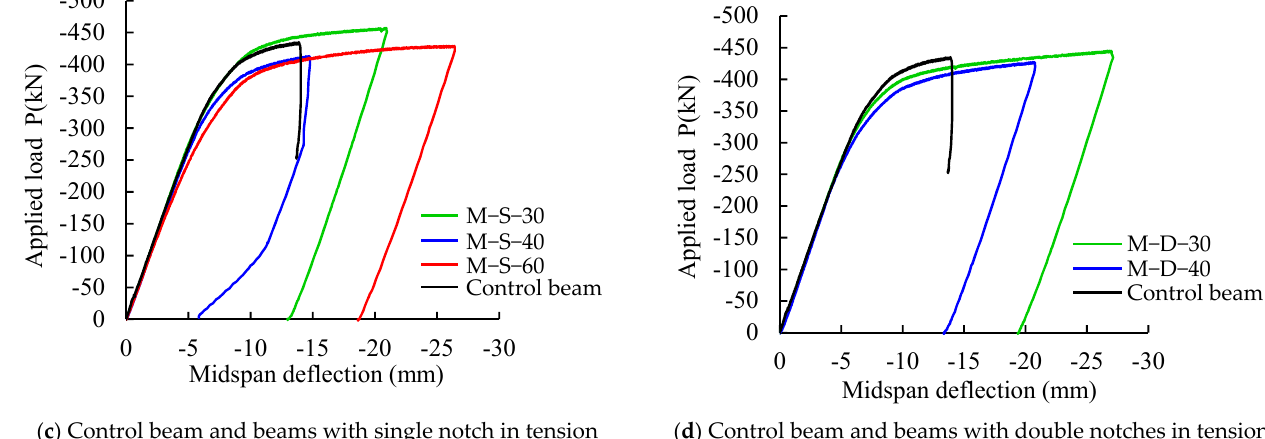
( a ) Control beam and beams with single notch in tension flange at quarter span.